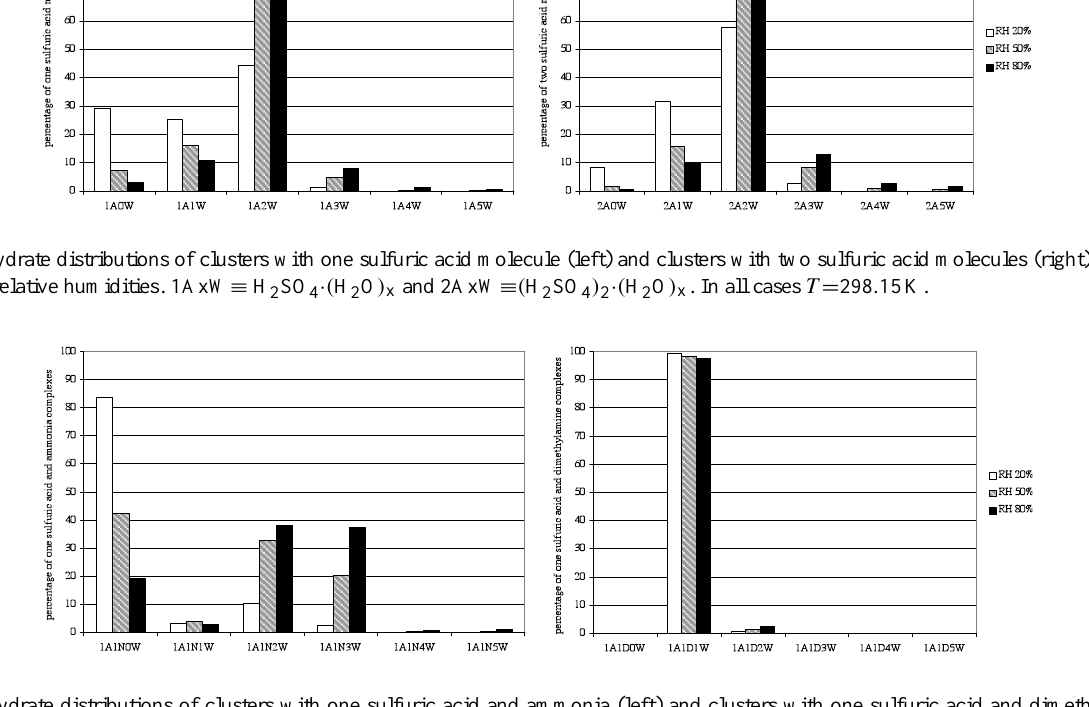
Fig. 9. Hydrate distributions of clusters with one sulfuric acid and ammonia (left) and clusters with one sulfuric acid and dimethylamine (right) at three different relative humidities. 1A1NxW ≡ H 2 SO 4 · NH 3 · ( H 2 O ) x and 1A1DxW ≡ H 2 SO 4 · ( CH 3 ) 2 NH · ( H 2 O ) x . In all cases T = 298 .